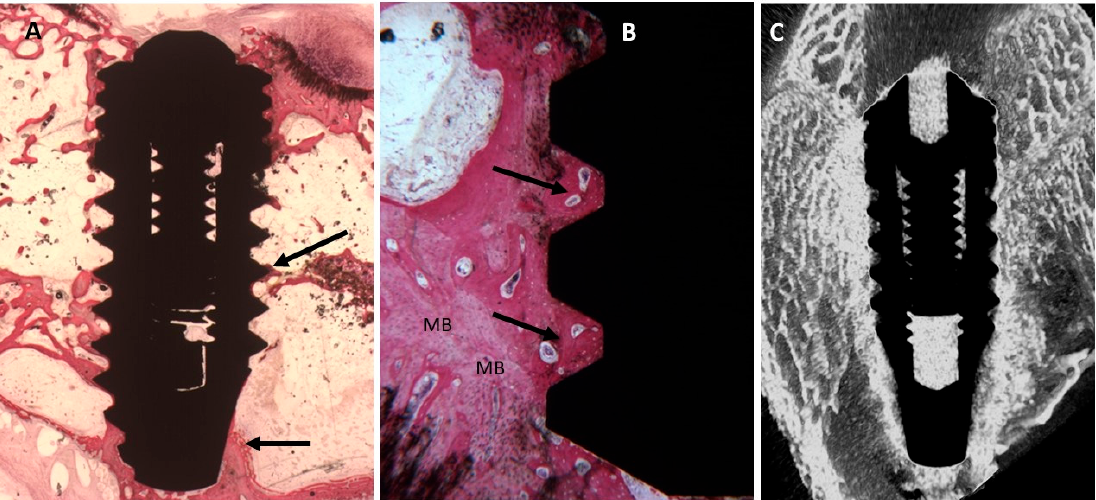
Figure 8. ( A ) Trabecular bone was more abundant around the dental implant (arrows). Toluidine blue and acid fuchsin staining 2×. ( B ) At higher magnification, mature bone (MB) was present around the implant surface and the concavities were completely filled by new mature bone (Arrows). Toluidine blue and acid fuchsin staining 50×. ( C ) Micro-CT scans along transection planes of the dental implant. Trabecular bone was present in contact with the dental implant and was also more than that in the control implant.